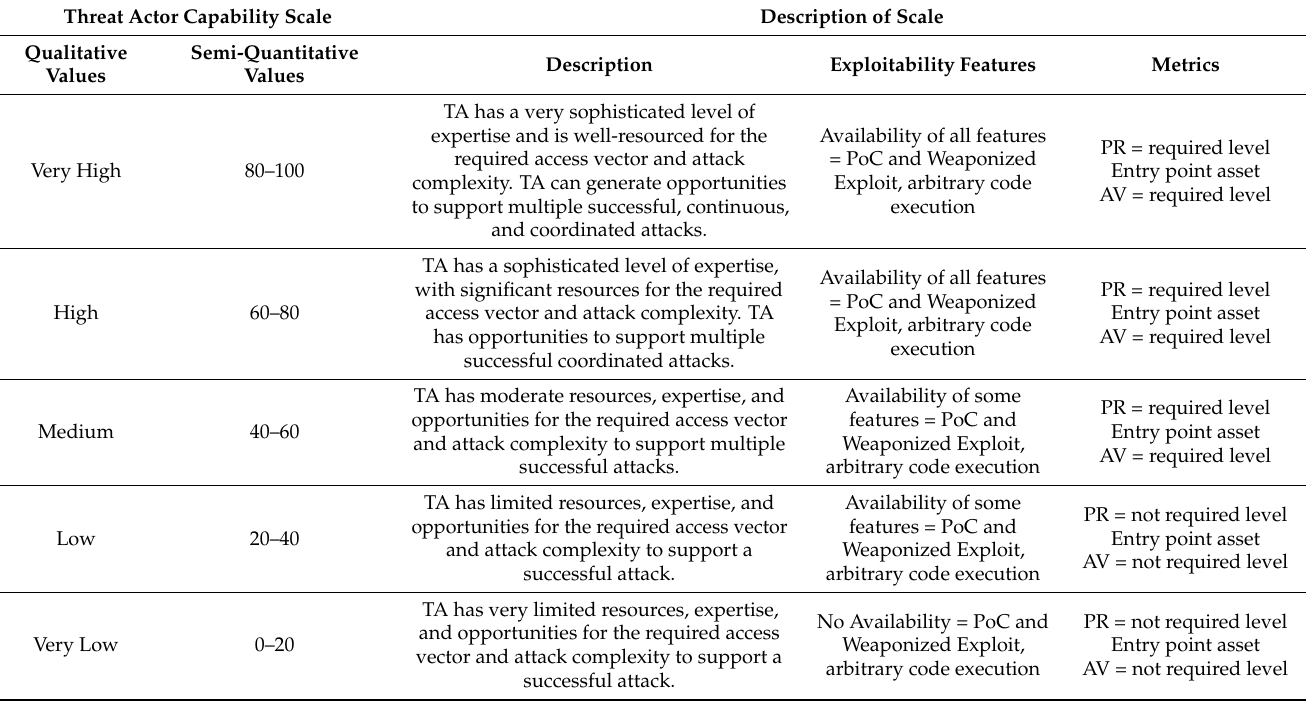
Table 2. Threat actor exploitation capability.